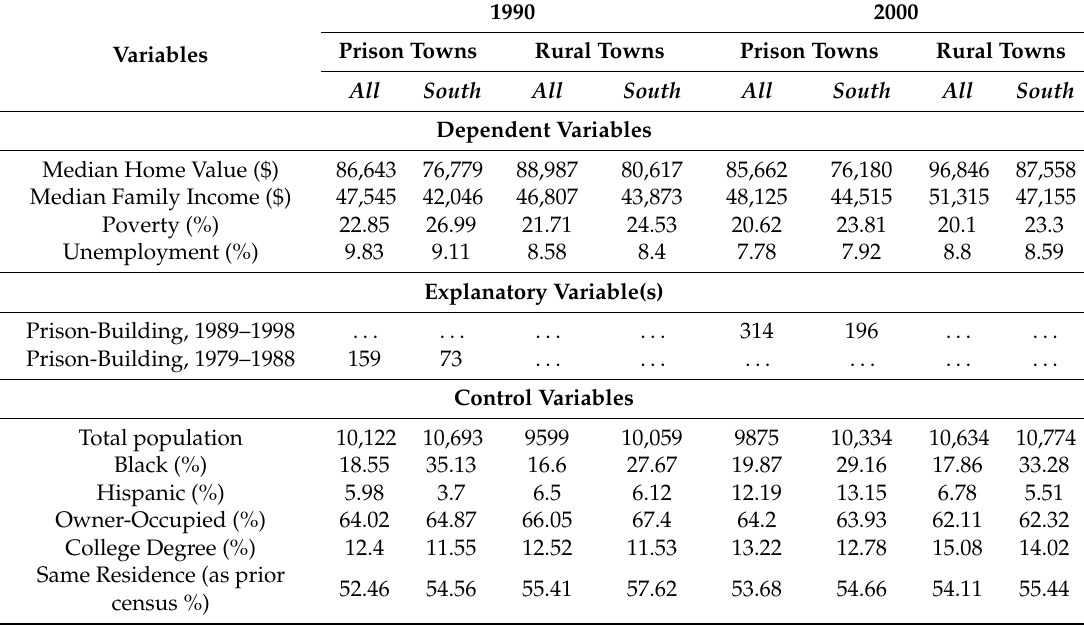
Table 3. Descriptive statistics of all variables included in the analysis from 1990 to